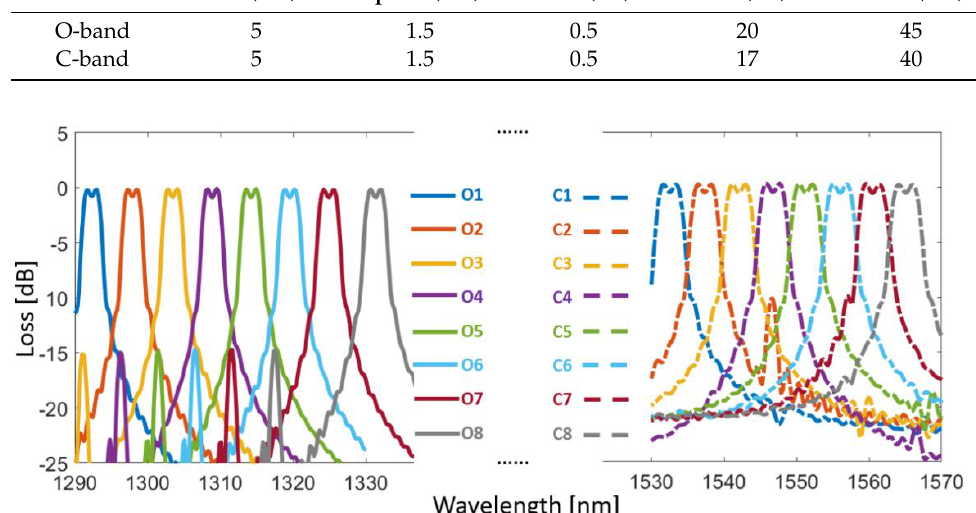
Figure 4. The WDM simulation results of 16 channels in the O-band and C-band, the loss of the O-